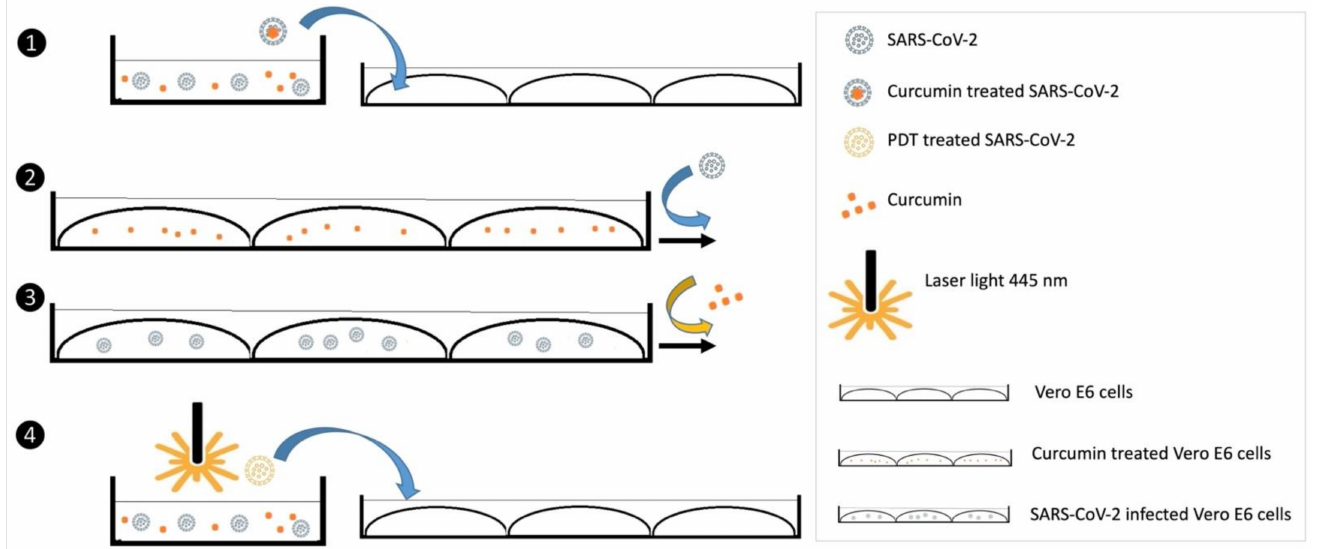
Figure 1. A graphical representation of the experimental settings employed: (1) the incubation of the virus with curcumin prior to its inoculation on cell culture (2) curcumin prophylactic treatment of cells (3) curcumin treatment of SARS-CoV-2 infected cells (4) curcumin based photodynamic treatment of